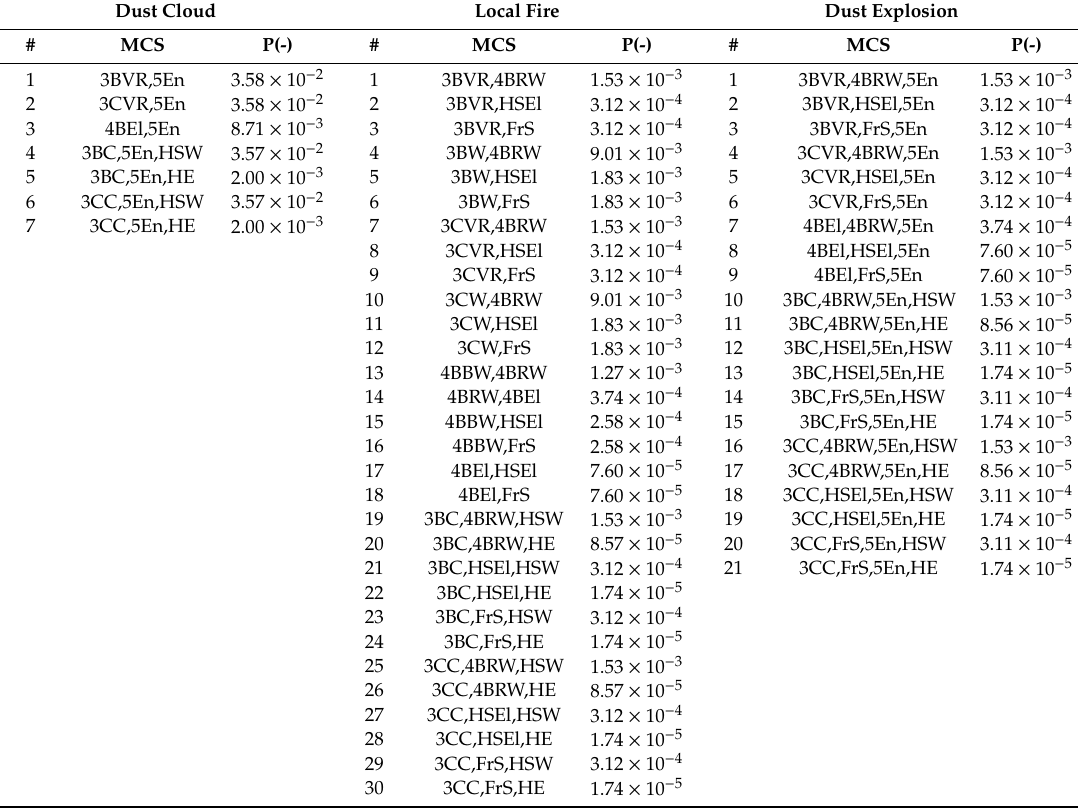
Table 9. Probabilities of occurrence P for every MCS identified. (MCS—Minimal Cut Sets) Dust Cloud Local Fire Dust